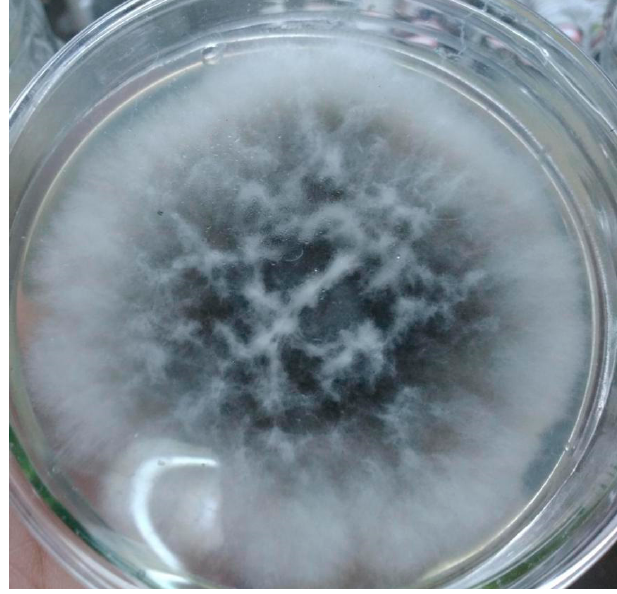
Figure 3. The purified strain in PDA medium.